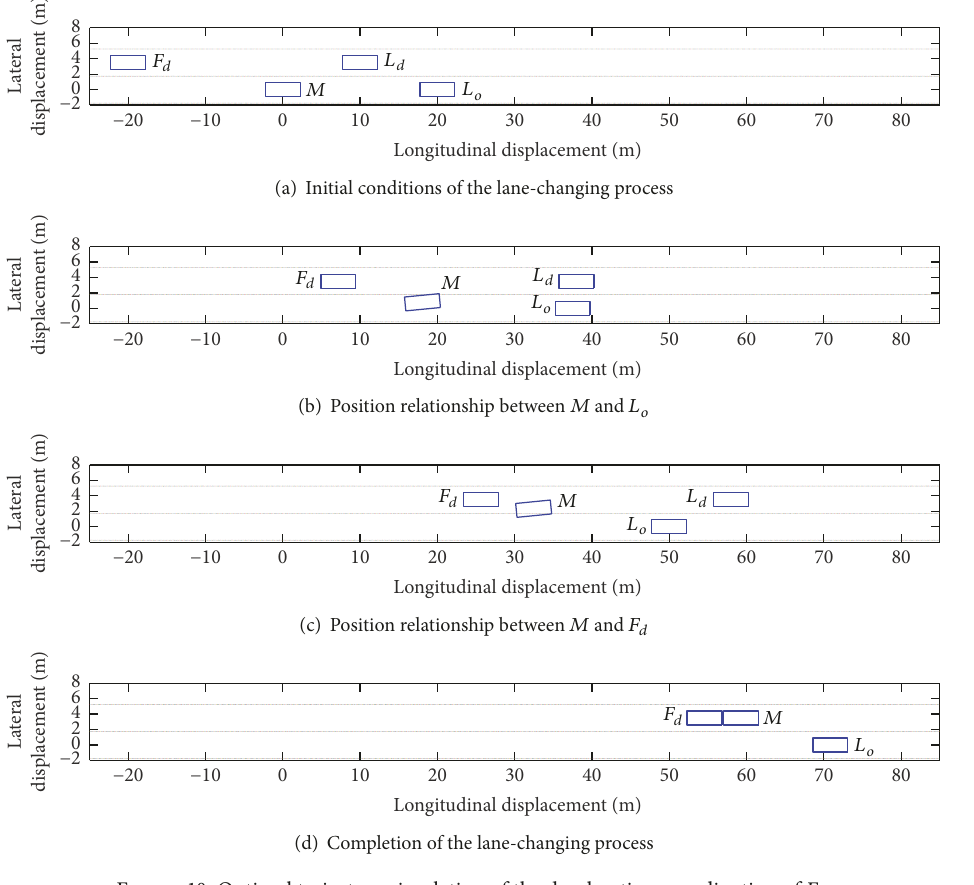
Figure 10: Optimal trajectory simulation of the deceleration coordination of 𝐹 𝑑 .